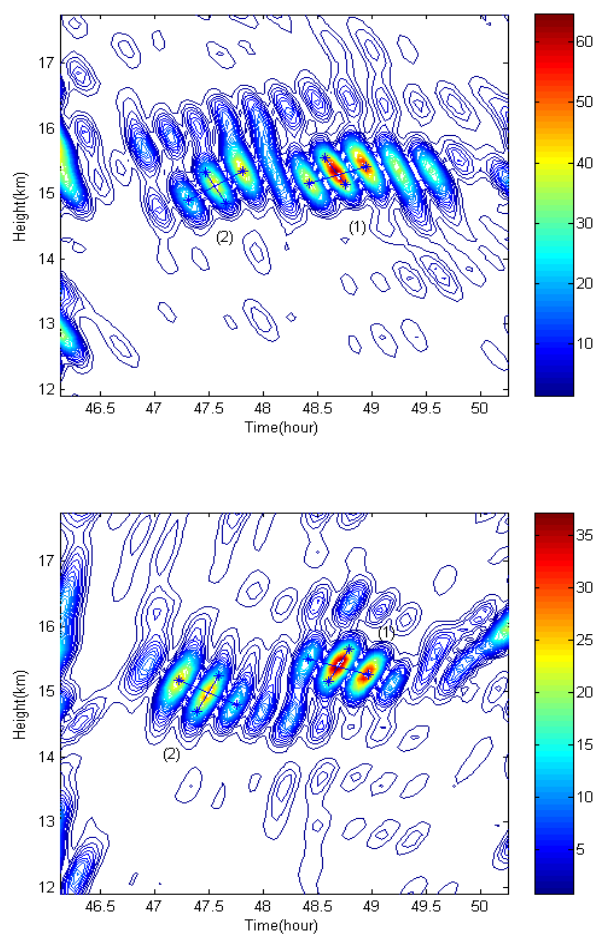
Fig. 9. Upper panel: a partial Range-Time plot of (δV ) 2 of zonal Fig.9 Upper panel: A partial Range-Time plot of ( ) 2 V δ of zonal velocity converted from the (z,t) } using window T2Z1, velocity converted from the subset { u 0 U ′ using window T2Z1, by the method of phase- and group velocity subset ( ) },{ tzu by the method of phase- and group velocity tracing; Lower panel: U The corresponding partial Range-Time plot of (δV ) 2 for the subset tracing; Lower panel: The corresponding partial Range-Time plot of ( ) 2 V δ for the { u 0 (z,t) } also using window ′ also using window T2Z1. subset ( ) },{ tzu D D